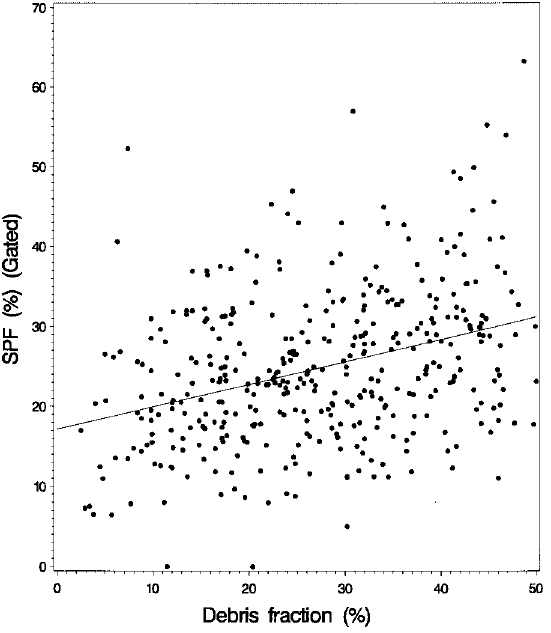
Fig. 3. Total SPF in cytokeratin-gated DNA histograms: Plot shows SPF as a function of debris counts, regression is 17 . 2 + 0 . 28 ×